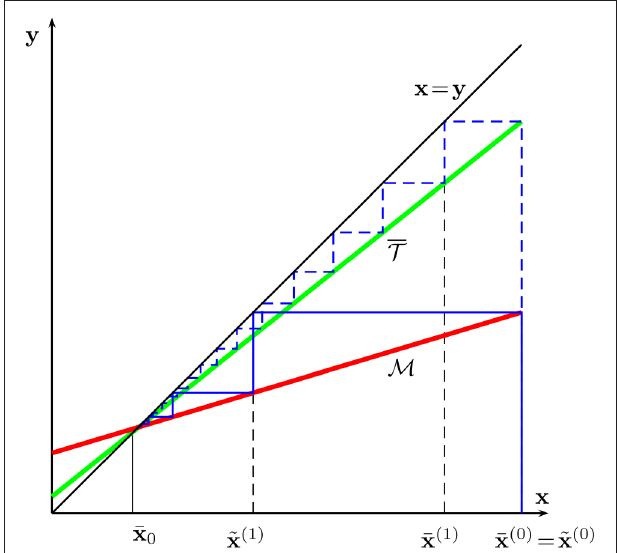
FIGURE 5 | Schematic illustration of the fixed-point iteration using operator T (32) (equivalent to GD) and for the modified operator M (36) (yielding HB